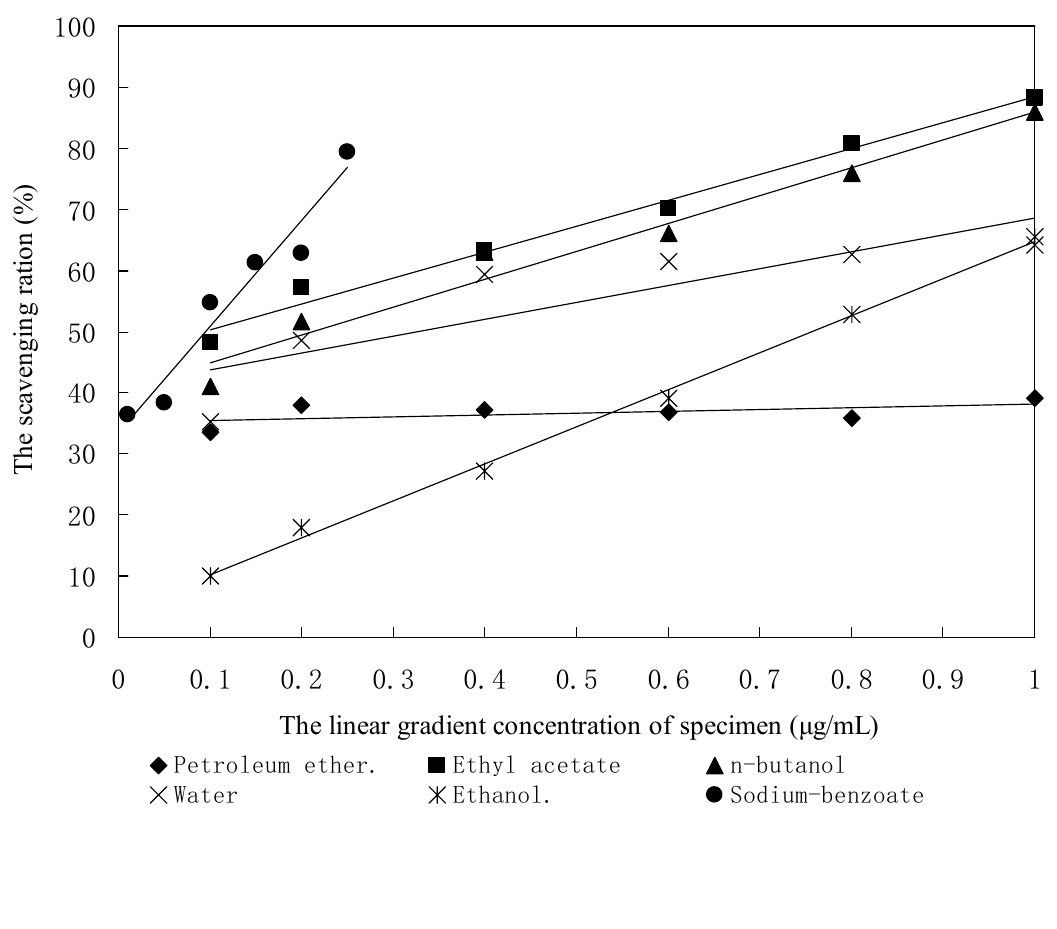
Figure 2. The regression lines of the scavenging abilities of